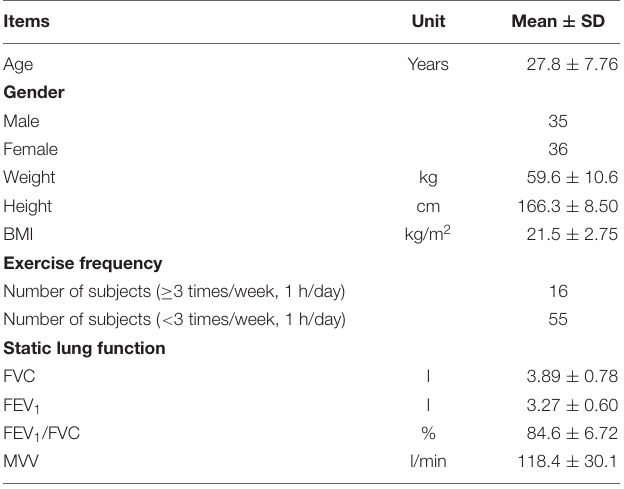
TABLE 1 | Baseline